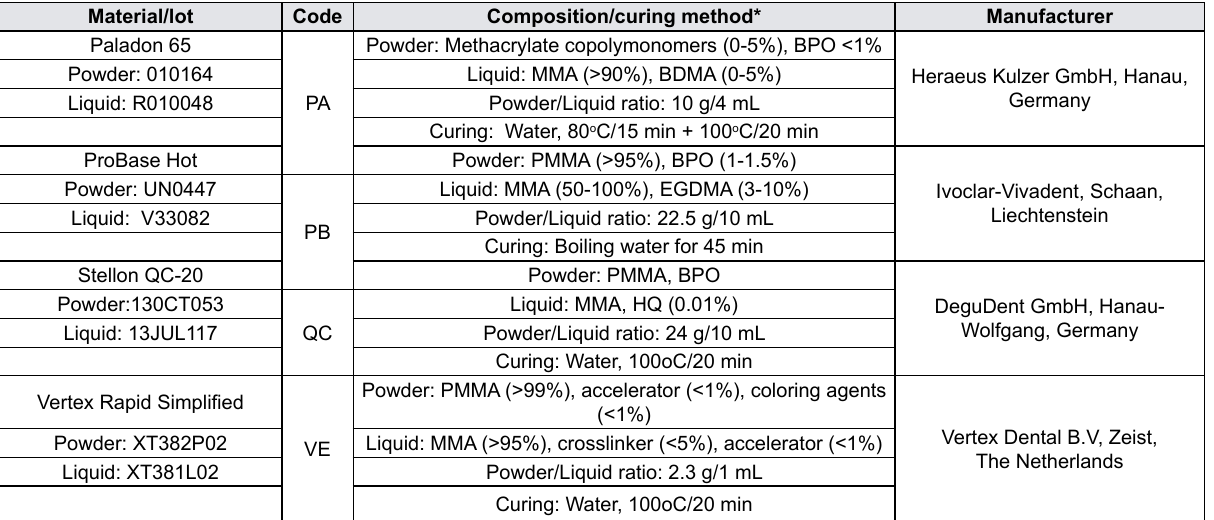
Figure 1- The heat-cured denture base materials used in the